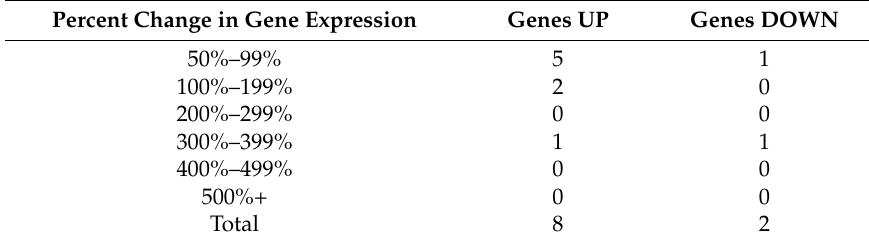
Table 19. Distribution of Genes Affected by GHK and Associated with Schwann Cells.